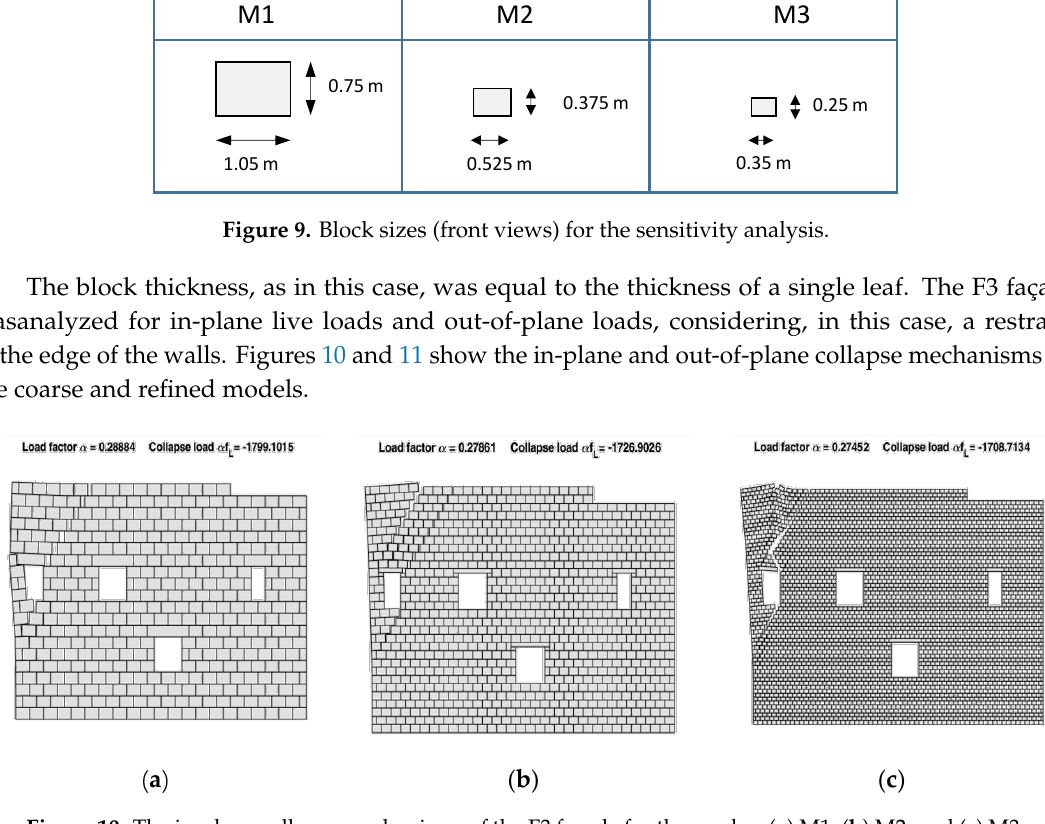
(b) Figure 8. The in-pane collapse mechanism provided by LiABlock_3D: ( a ) the F1 for live loads along the negative x-axis; ( b ) the F4 façade for live loads along the negative y-axis. Table 1 reports the comparison between the load factors for the out-of-plane mechanisms, calculated by applying LiABlock_3D according to both the associative and the non-associative friction behavior, and by carrying out hand-made calculations according to a conventional linear kinematic analysis. It is interesting to note that the analytical solution was included within the two load factors given by the software in the cases of associative and non-associative behaviors. This was mainly due to the fact that the numerical models took into account the friction behavior on the vertical contacts between the two leaves, which is usually neglected in analytical calculations, leading to an overall increase of resistance. Table 1. Numerical and analytical load factors for the out-of-plane analysis of the four façade macro- elements. Macro- Element